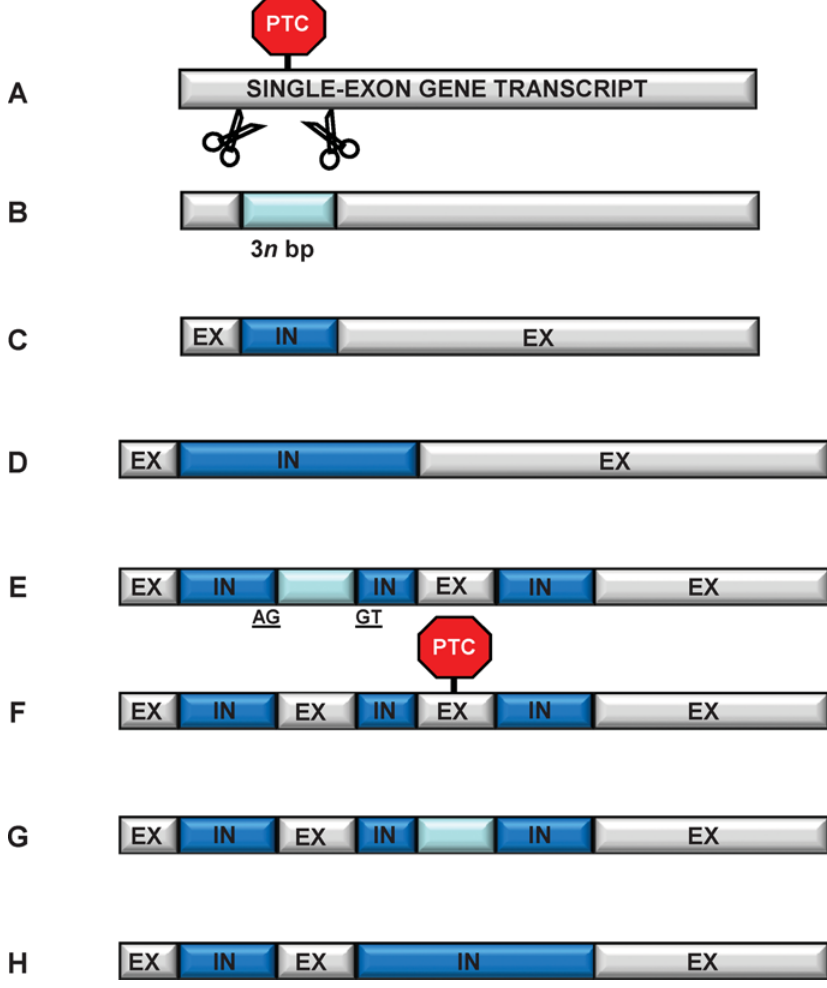
Figure 2. Schematic Example for a Hypothesized Temporal Succession of Exonization and Intronization Processes (A) A PTC-containing exonic region is fortuitously spliced. (B) If the region spliced has a length that is a multiple of 3, and its absence is not detrimental to the functionality of the coded protein, the exonic region may start being skipped, with its incorporation in the mature mRNA gradually decreasing, essentially undergoing a phase of alternative splicing (indicated in light blue). (C) The constitutive intron (IN) is created, flanked by two constitutive exons (EX); and (D) may grow larger (for example, as a consequence of insertion accumulation). (E) A second constitutive intron arises downstream in a way similar to that described for the previous intron, while a process of exonization starts within the previous intron. (F) The novel, initially alternatively spliced exon now becomes constitutively spliced, while the exon downstream of it acquires a PTC and may start the process of intronization. (G) The intronization process of the PTC-containing exon undergoes a phase of alternative splicing, which subsequently leads to (H) the technical loss of one intron and one exon and the creation of a single, larger